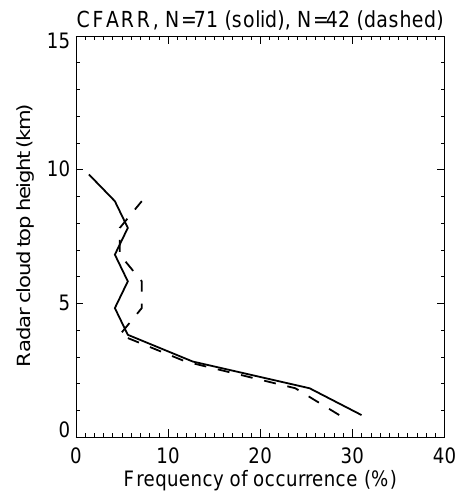
Fig. 2. Same as Fig. 1 for the CFARR site, with median cloud-top heights calculated over a 4800s time period centred on MODIS start of acquisition